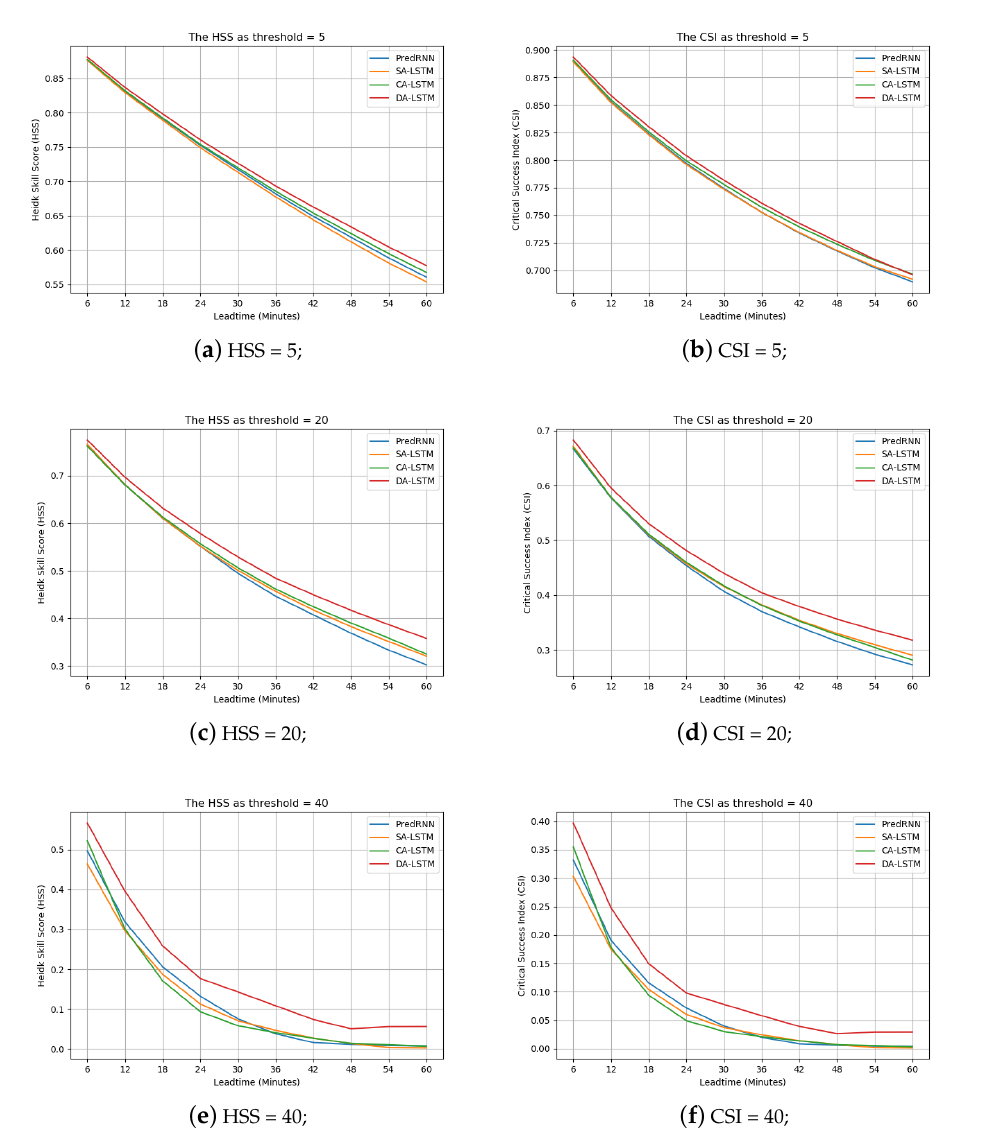
Figure 15. The performance changes against different nowcast lead times in attention mechanisms ablation study in terms of HSS and CSI scores. (Best view in